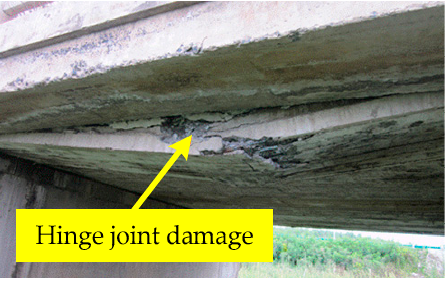
Figure 1. Hinge joint damage on a simply supported slab bridge.